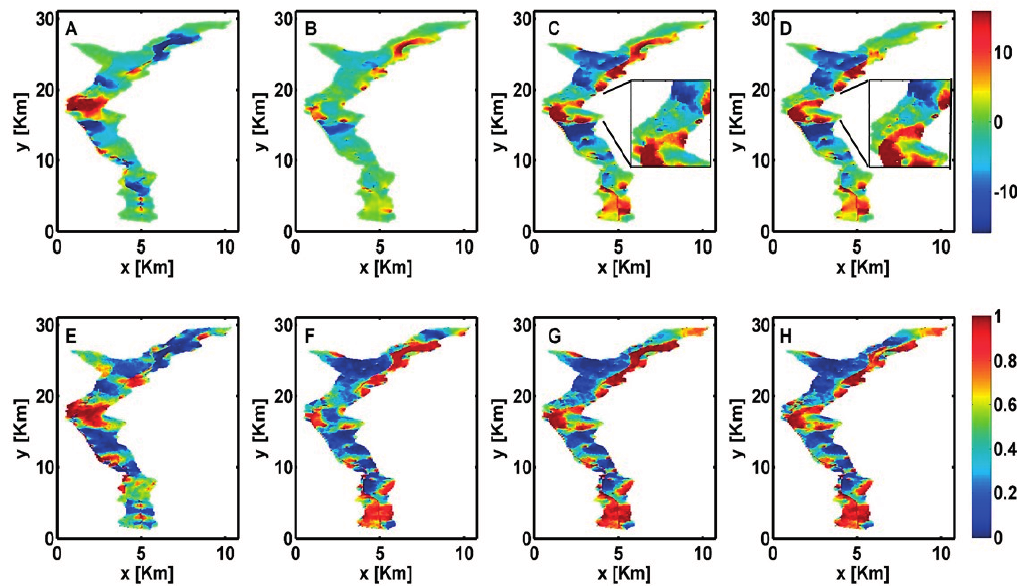
Figure 11. Maps with the mean ( A to D ) of the coefficient s (m 2 /d) computed for the Scenarios RS05, PW2, PW5A and PW5B, and the probability of exceeding the